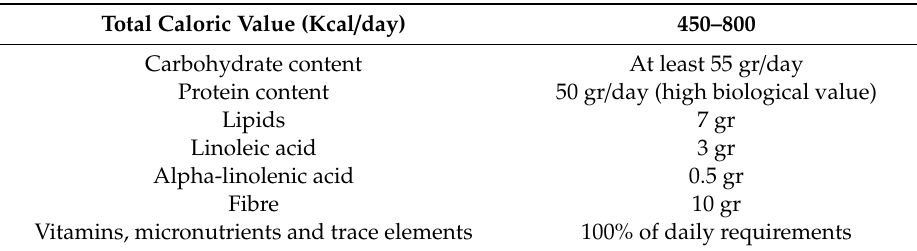
Table 4. VLCD main